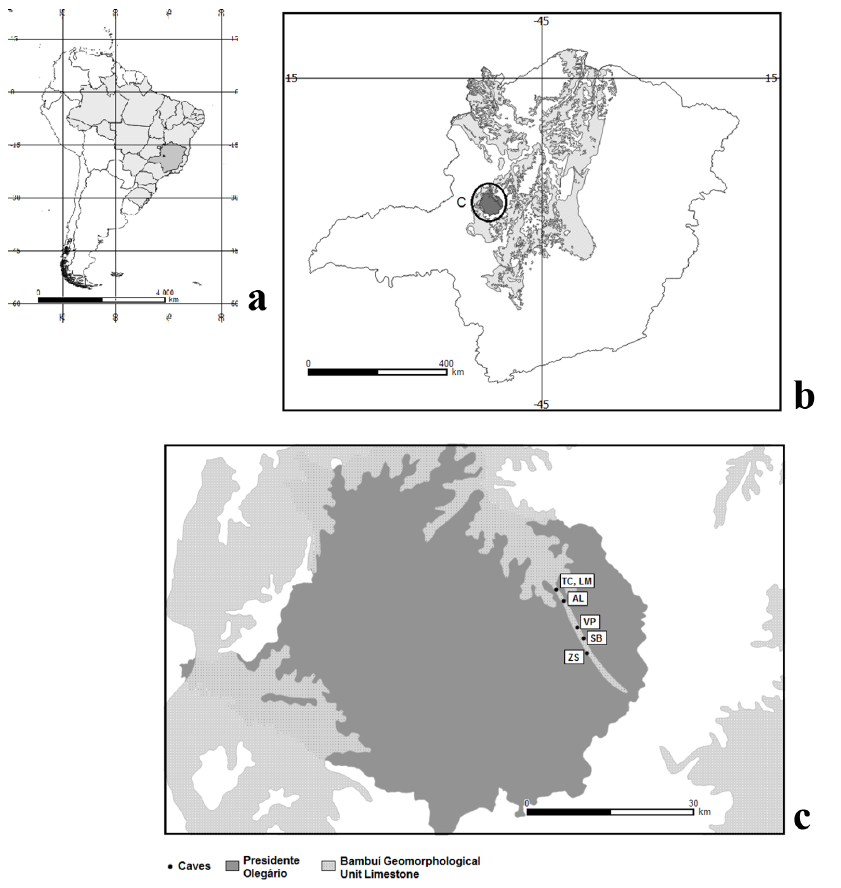
Figure 1 - Presidente Olegário karst area, Minas Gerais, Brazil. (a) South America; (b) Minas Gerais state and Presidente Olegário municipality; (c) Sampled caves. VP = Lapa Vereda da Palha cave, SB = Lapa da Fazenda São Bernardo cave, ZS = Lapa Zé de Sidinei cave, AL = Lapa Arco da Lapa cave, LM = Lapa do Moacir cave, TC = Toca do Charco